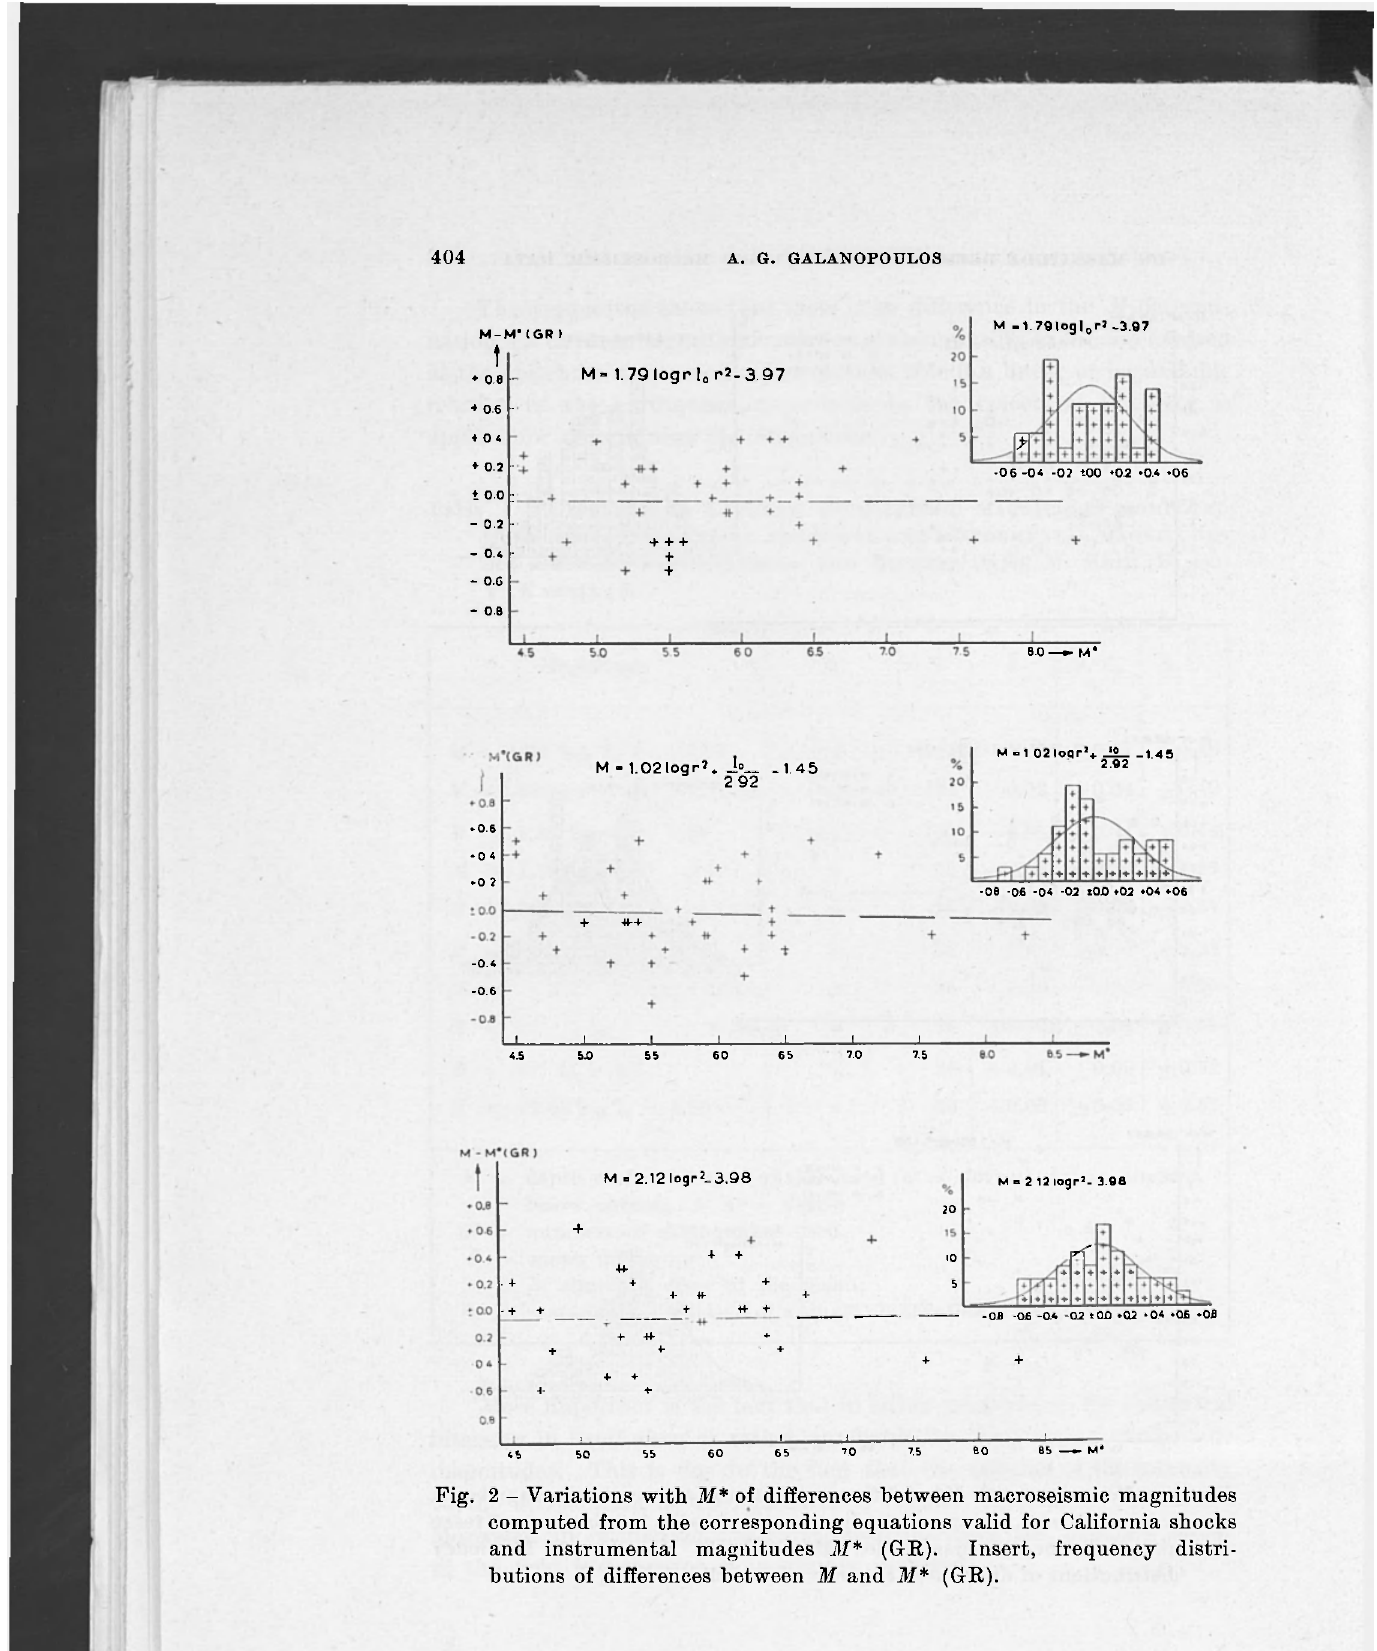
Fig. 2 - Variations with 31* of differences between macroseismic magnitudes computed from the corresponding equations valid for California shocka and instrumentai magnitudes M* (GR). Insert, frequency distri- butions of differences between M and 31*